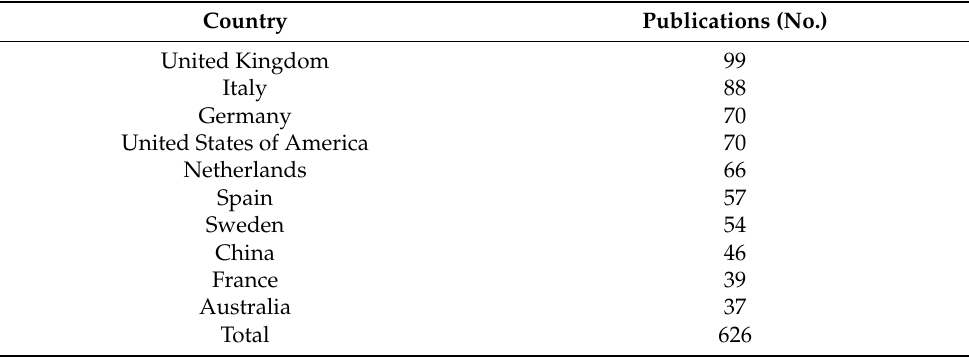
Table 3. The 10 countries most commonly associated with NBS.